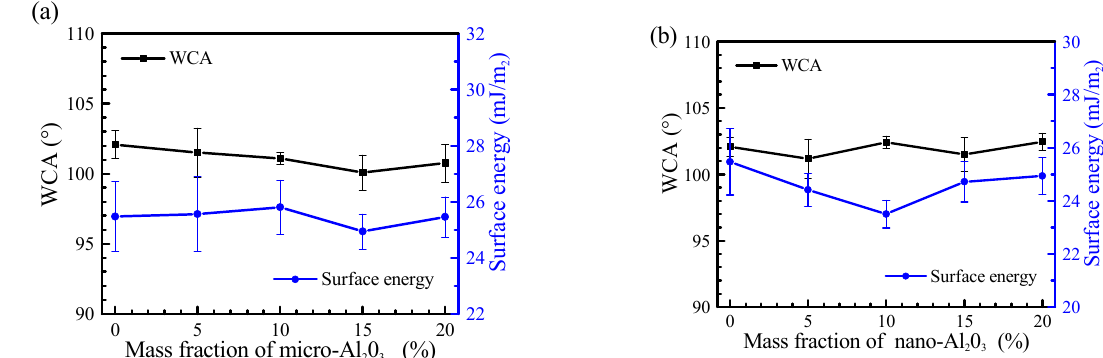
Figure 4. Effect of addition amount and particle size of alumina on WCA and surface energy: ( a ) Micro-alumina, ( b ) Nano-alumina.